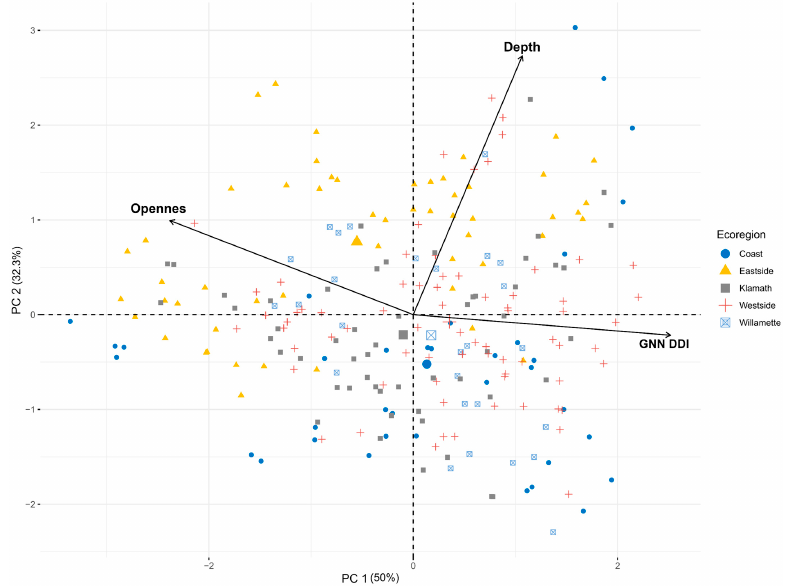
Figure 7. Ordination plot of all 243 locations sampled during the study. PC 1 and PC 2 axis are label with the amount of variation they explain. Depth, openness, and GNN DDI vectors are oriented relative to how much they contribute to PC 1 and PC 2. Our openness metric has a negative relationship with GNN DDI. 3.2.2. Depth and Openness ANOVA There were significant differences in the depth values between stands at each of the 100 angular increments (all p values < 0.05 with the majority < 2.2 × 10 − 16 ). There were also significant differences in the openness values between stands at each of the 100 angular increments (all p values < 0.05 with the majority < 2.2 × 10 − 16 ). With p values less than 0.05 for an ANOVA test, we accept the null hypothesis that at least one of the group means was significantly different than the others. When grouped by ecoregion, there was a significant difference between all parings of the depth and openness metrics except for the depth metric between ecoregions of Kla- math mountains and the coast range, as well as Willamette valley and the westside of the cascade mountains (Figure 8). Our stands in the eastside of the cascades were most